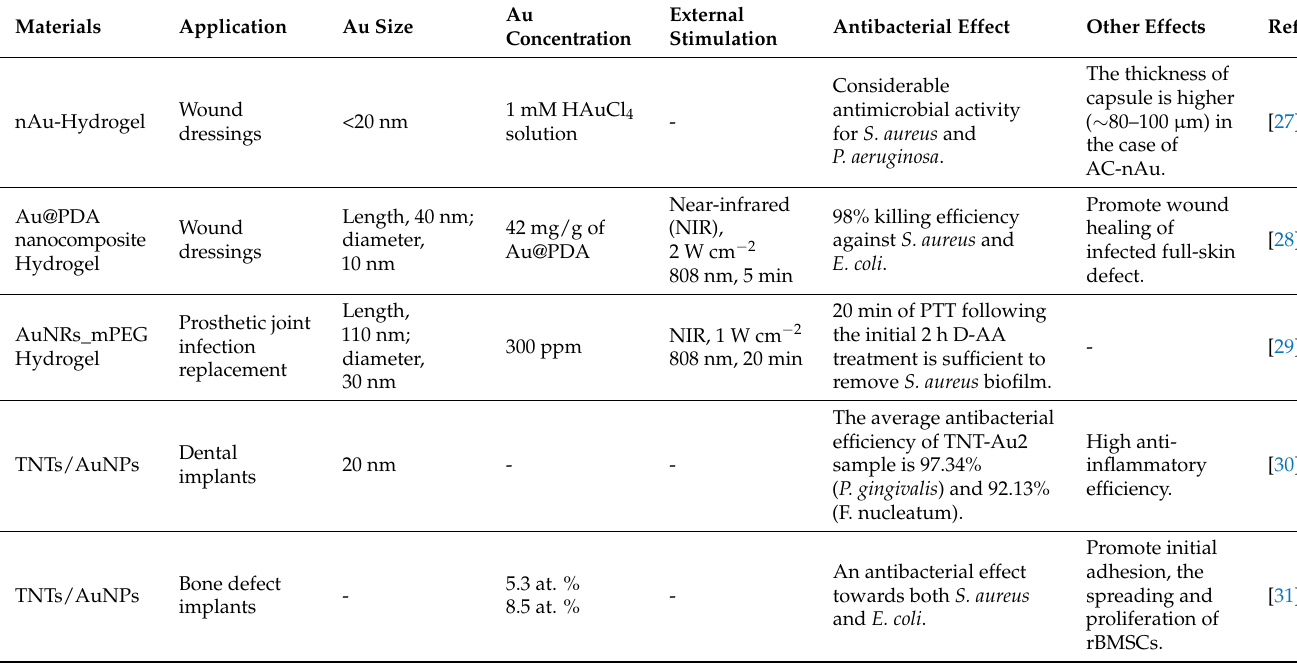
Table 1. The antibacterial effects and other effects of implant materials modified by various gold